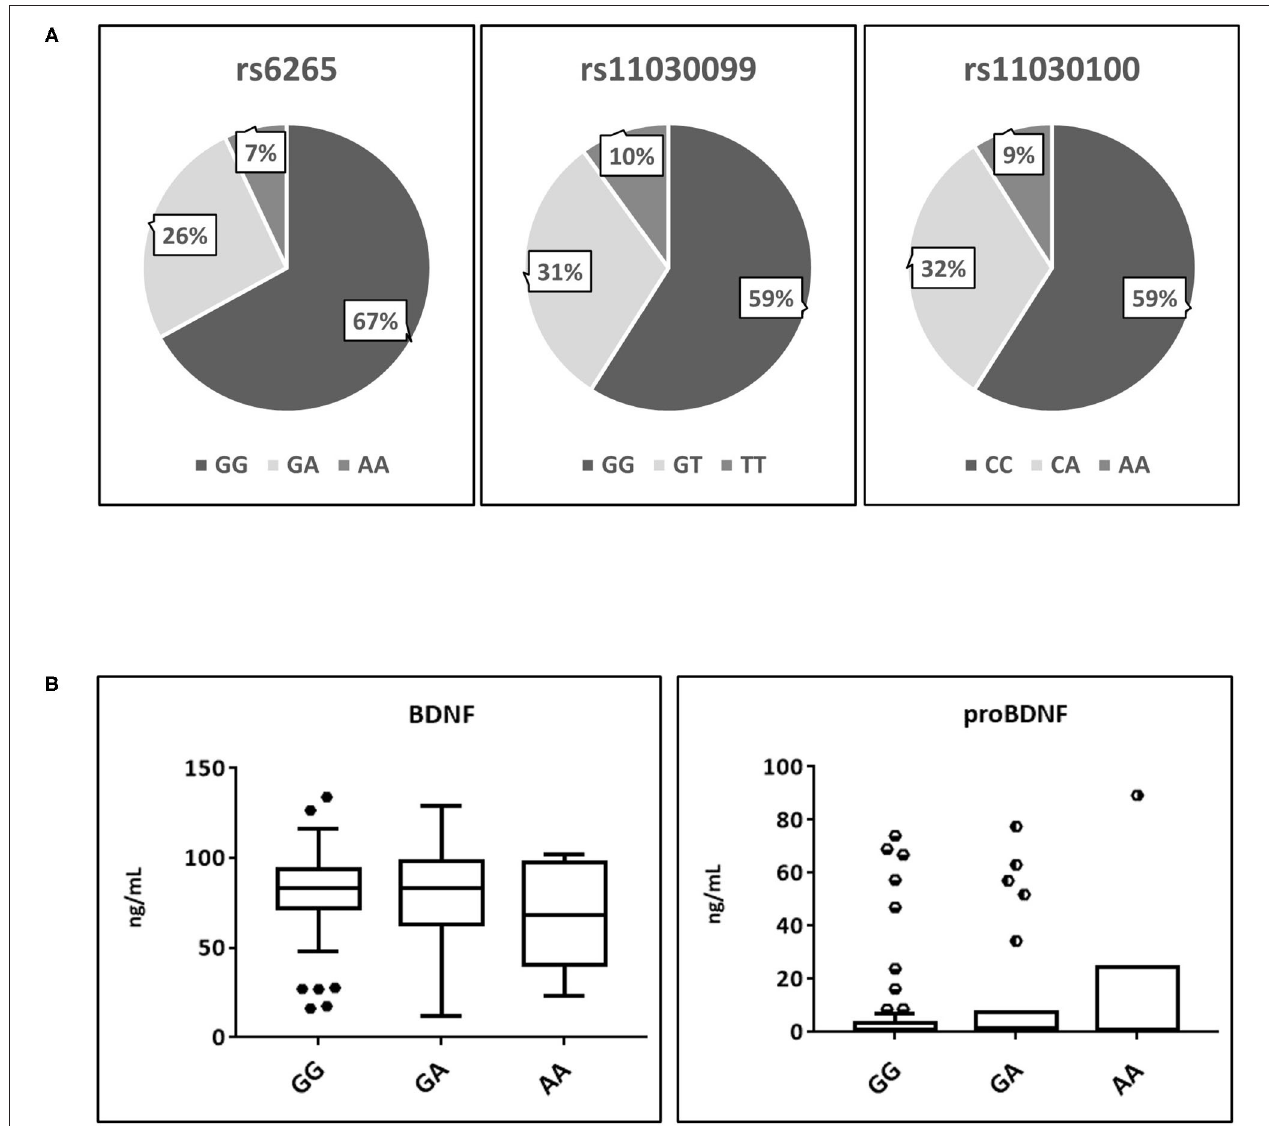
FIGURE 2 | Analysis of the main polymorphisms affecting proBDNF and BDNF secretion. (A) Frequency percentages of the three polymorphisms. (B) BDNF and proBDNF serum distribution affected by rs6265 polymorphism. BDNF, brain derived neurotrophic factor; proBDNF, pro-brain derived neurotrophic factor. Symbols outside the box plots indicate the